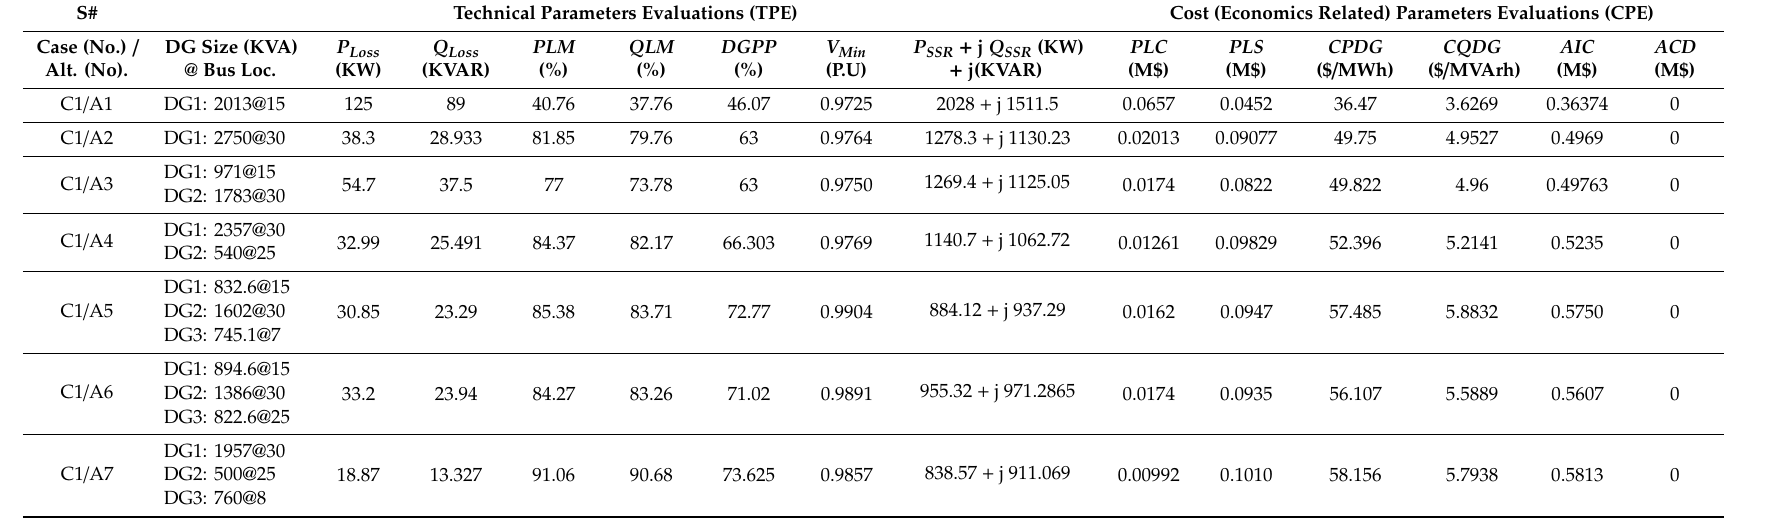
Table 5. Techno-economic evaluation analysis in case 1 (C1_NL) for 33-bus MDN.